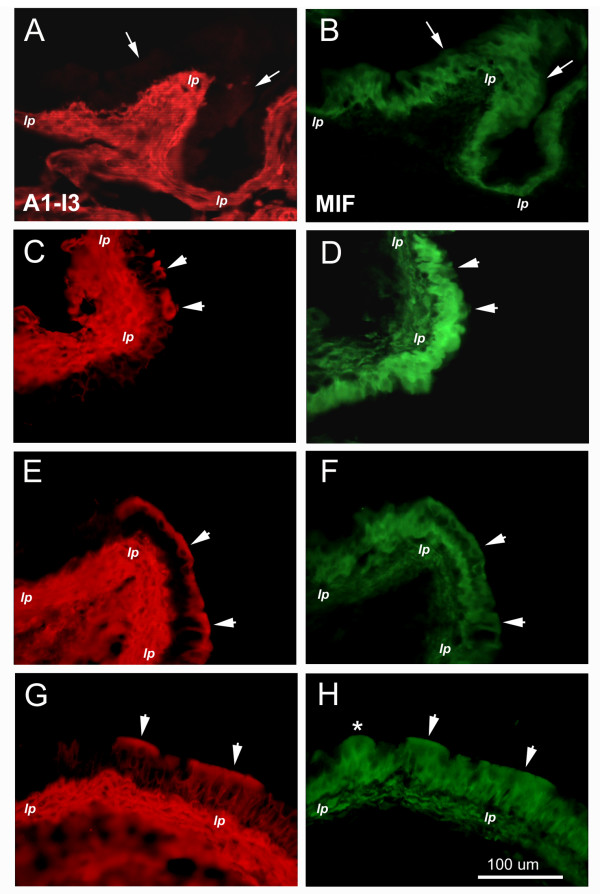
Colocalization of MIF/A1-I3 in umbrella cells after SP-treatment. Dual-immunofluorescence for A1-I3 and MIF in bladder sections from saline (A, B) and SP-treated rats (C–H). Bladders from saline-treated rats showed no A1-I3 in the urothelium (A; edge of unstained urothelium marked by long arrows) while the lamina propria (lp) showed significant A1-I3 immunostaining. On the other hand, MIF is present in the urothelium of saline-treated rats (B), mainly in basal and intermediate cells. Representative sections from three (3) different animals show that after substance P treatment, A1-I3 immunostaining is seen in umbrella cells (C, E, G; arrows) that also co-localized MIF (D, F, H; arrows). In addition, increased staining in the lamina propria (lp) can be observed (D, F, H). Asterisk (H) shows area of superficial urothelium with MIF immunostaining but lacking A1-I3 immunostaining (G). Calibration bar = 100 um.